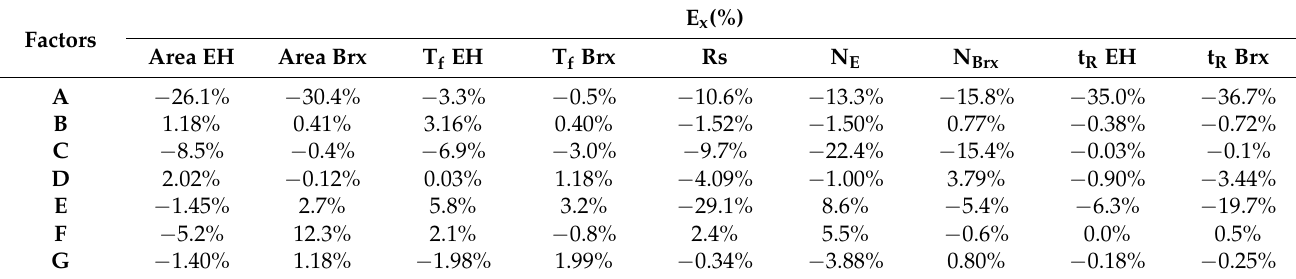
Table 6. The normalized effect E x (%) on the